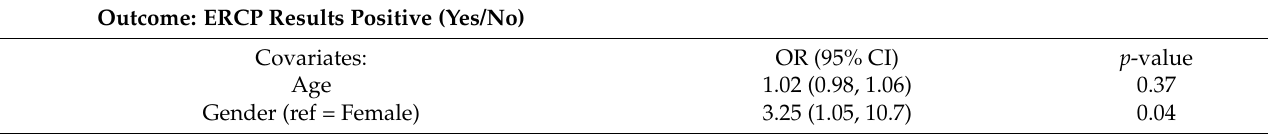
Table 4. Univariate analysis for positive ERCP